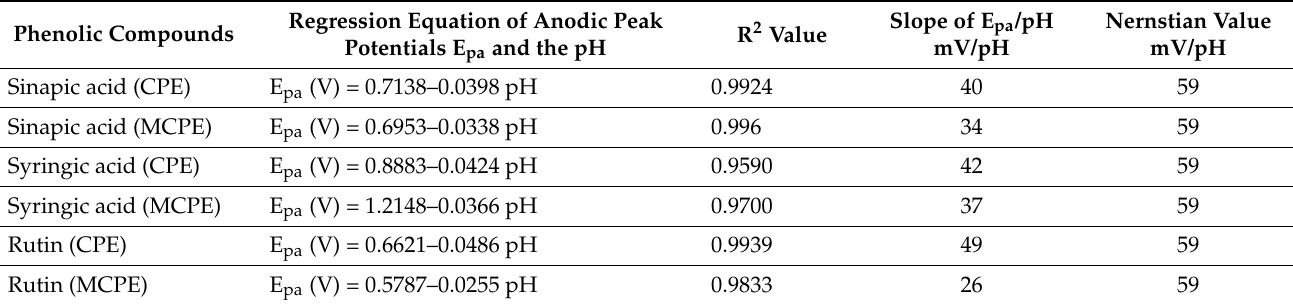
Table 1. Linear regression equation of anodic peak potentials E pa and pH of the phenolic compounds with their slopes respectively reported for cyclic voltammetry method employed in determining the pH on the electrochemical behavior of the phenolic compounds at bare CPE and MCPE.